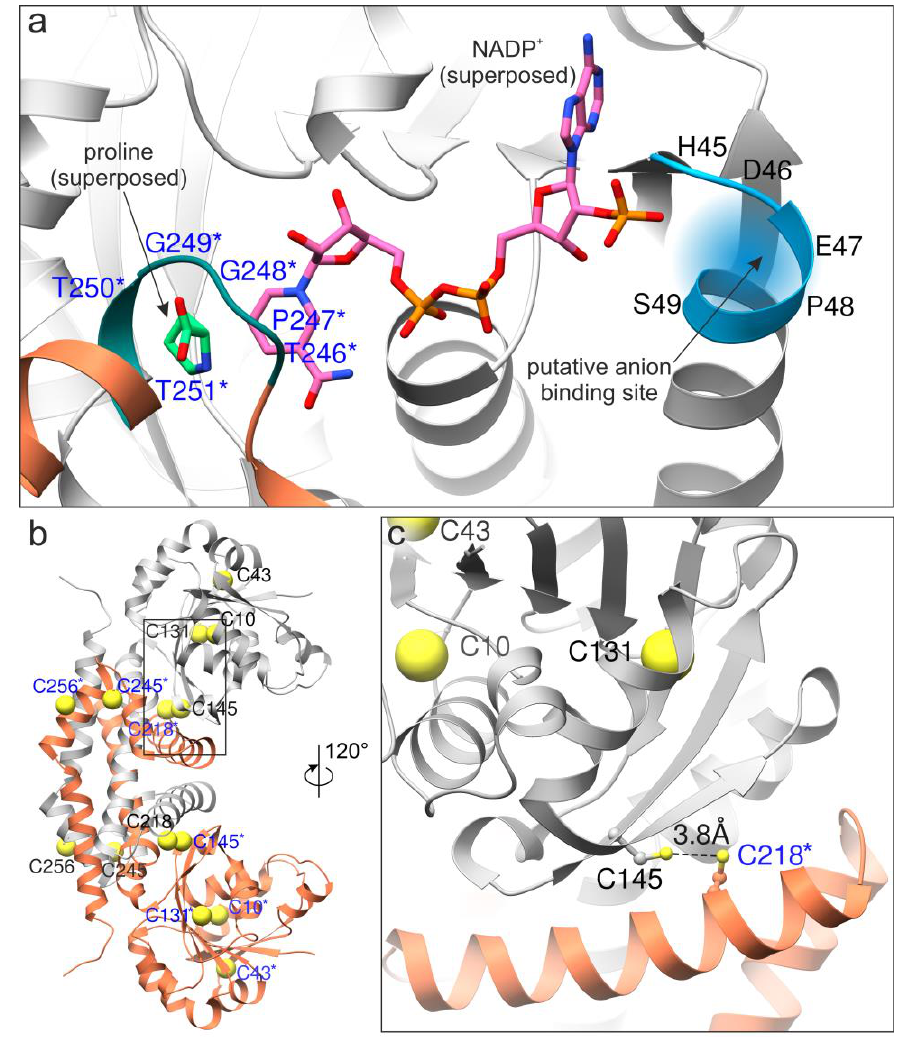
Figure 9. Identification of the putative sites of anion binding and disulfide formation. The coenzyme binding site with superposed NADP + (from PDB ID 5bsg, [35]) and proline (PDB ID 5bsh) is shown in (panel a ); the two subunits are gray and coral, respectively. Residues from the second subunit are labeled in blue and marked with asterisks. The anions most likely compete with the 2′-phosphate of NADPH. (Panel b ) shows cysteine residues in Sc P5CR (Sγ atoms shown as yellow spheres), whereas a close-up over the Cys145-Cys218* pair (ball-and-stick) is presented in (panel c ).